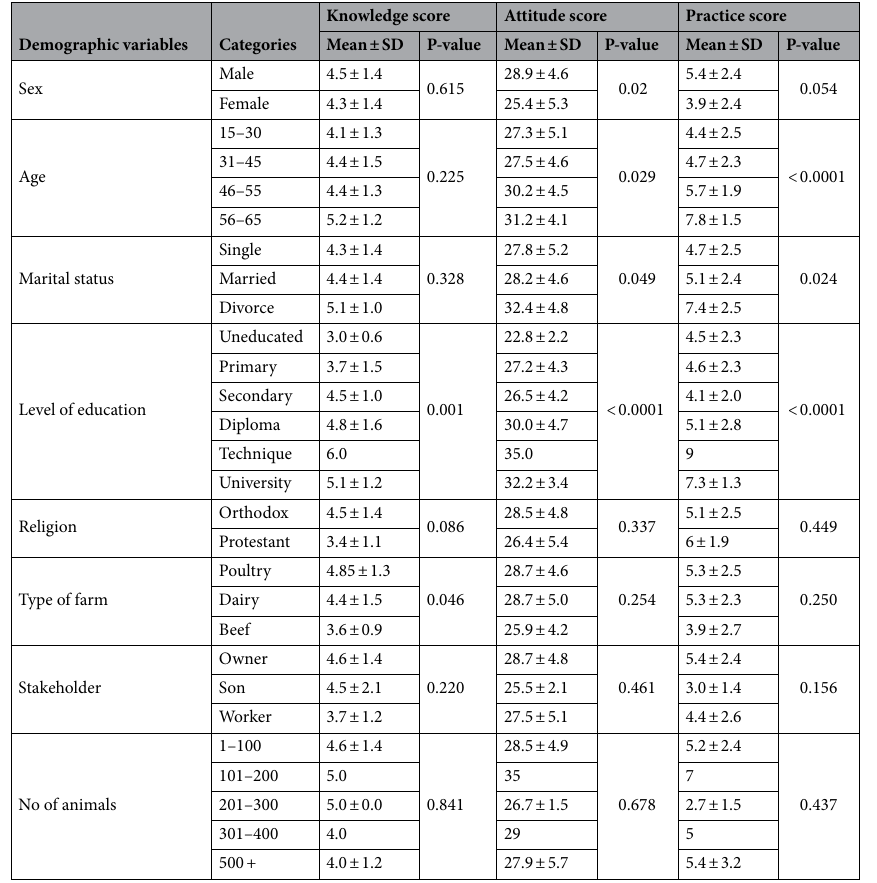
Table 4. Relation between participants’ characteristics and mean scores of knowledges, attitude and practices on antibiotic resistance and